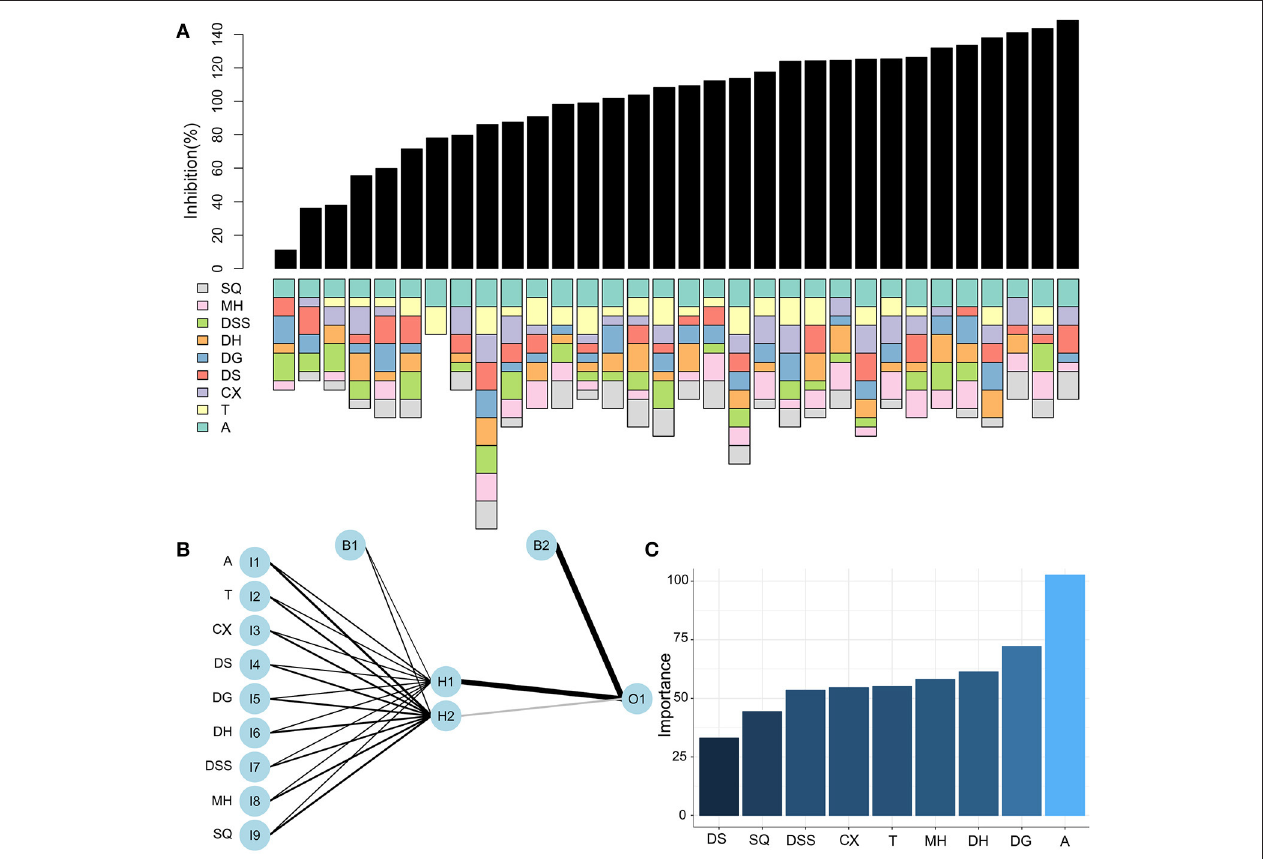
FIGURE 3 | Results of FSC optimization in generation 1. (A) Efficacy and drug composite of the drug combinations in generation 1. The length of the colored bars underneath the inhibition data indicates the coded amount of dose for each drug. (B) The architecture of the neuron network used to train the 32 data points in Generation 1. (C) The relative importance of the drugs based on this model was calculated using Garson’s algorithm. And the top five drugs were investigated in the following study. A, aspirin; T, ticagrelor; CX, ligustrazine from ChuanXiong; DS, Salvianolic acid B from DanShen; DG, ferulic acid from DangGui; DH, 5-hydroxymethyl furfuraldehyde from DiHuang; DSS, garlicin from DaSuan; MH, forskolin from MaHouQiaoRuiHua; SQ, panax notoginsenosides from Sanqi.